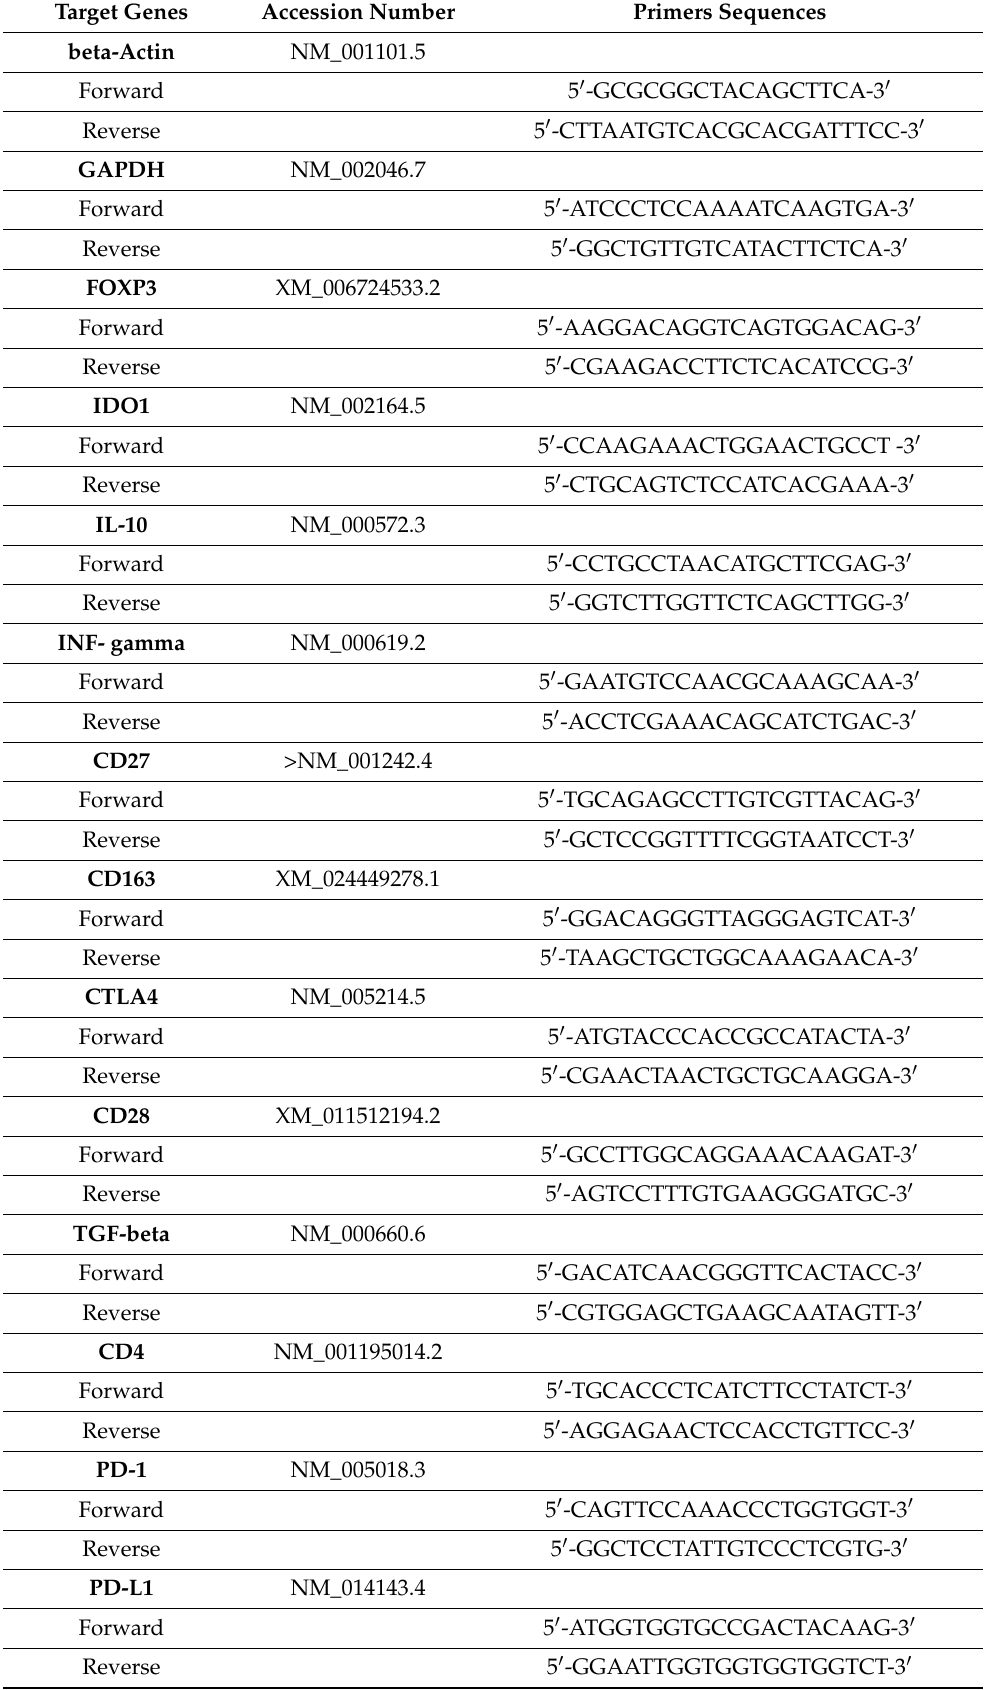
Table 2. List of gene specific primer sequences used in